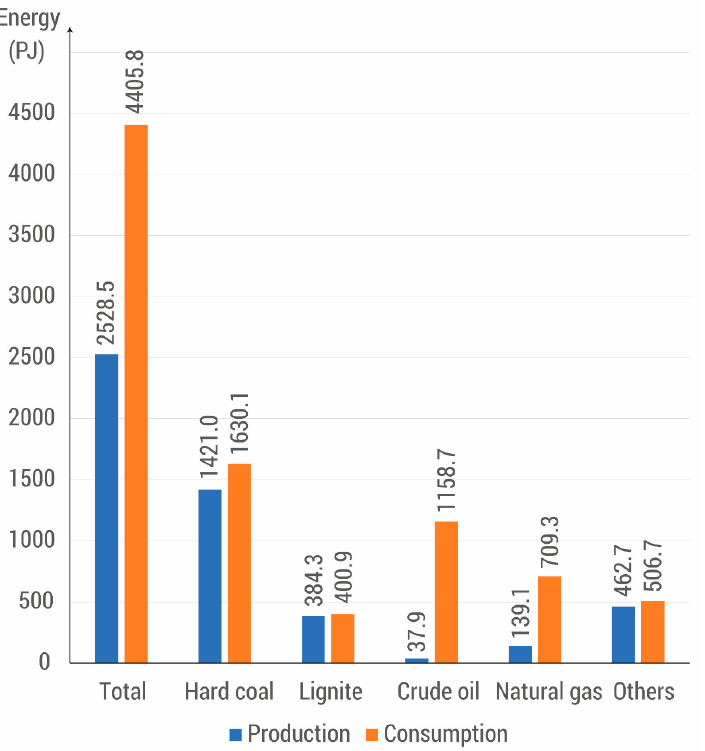
Figure 1. The primary energy production and the total energy consumption in Poland in 2019. Data were obtained from the Polish Central Statistical Office [6].